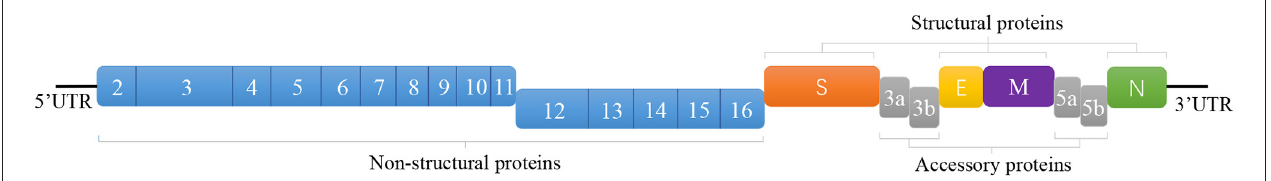
FIGURE 1 | The infectious bronchitis virus genome structure from 5 ′ to 3 ′